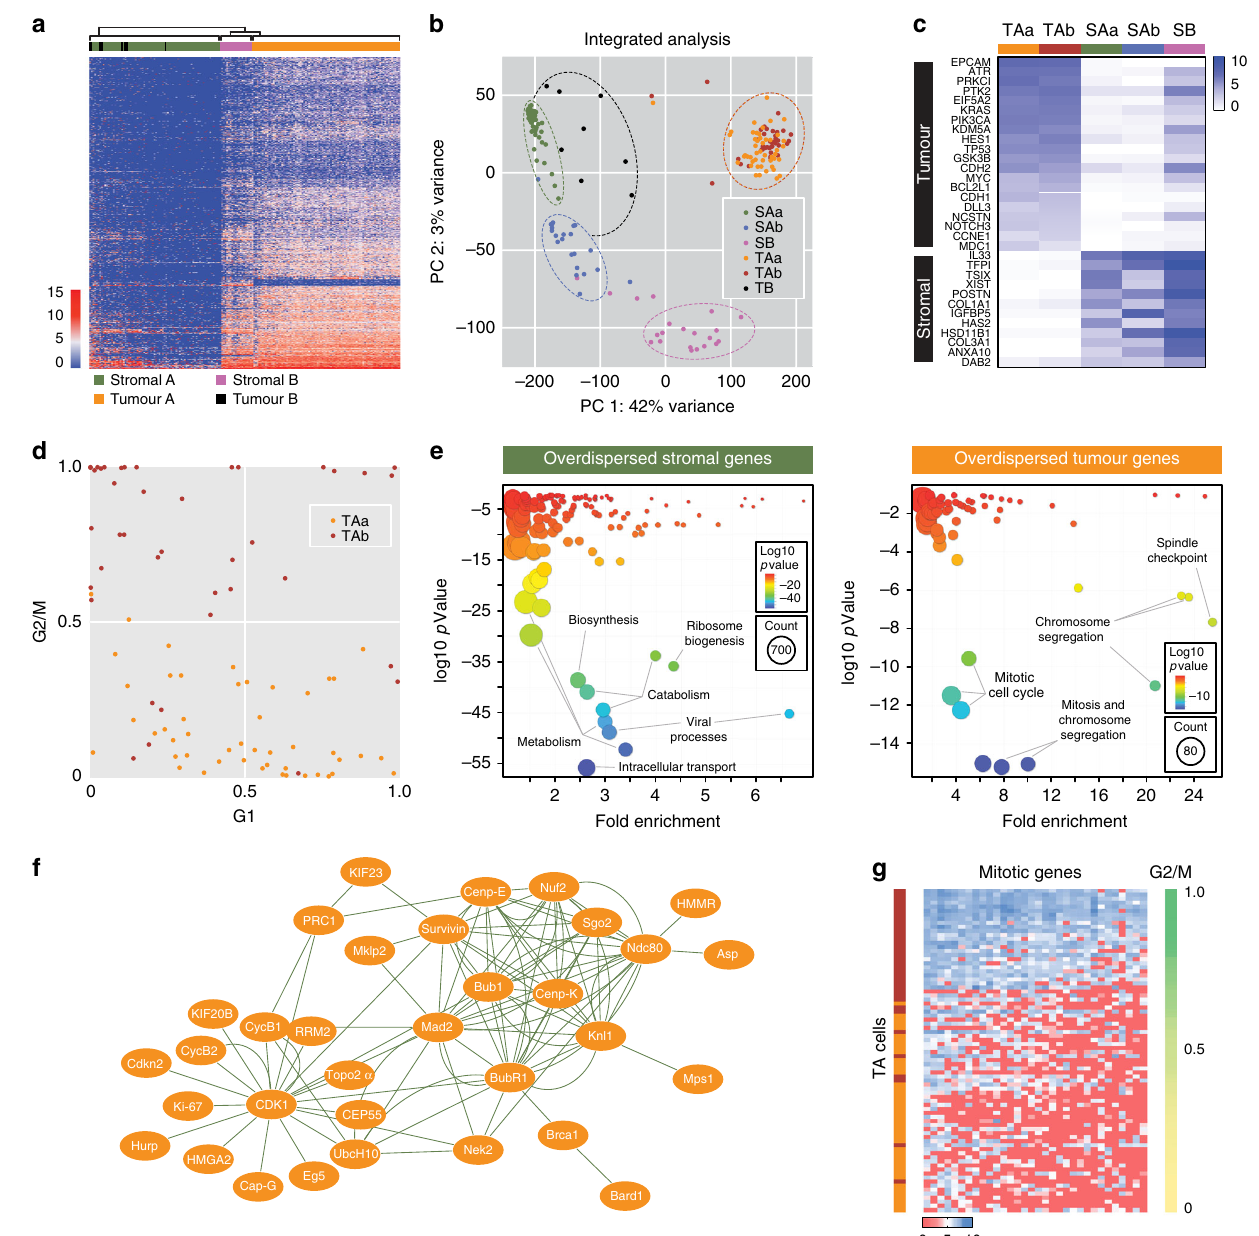
Fig. 4 Fluidigm single-cell transcriptomics. a Hierarchical clustering of gene expression pro fi les distinguishing stromal and tumour cells from chemo-naïve OCM.38a. b Principal component analysis integrated with pathway analysis showing subpopulations of tumour and stromal cells. c Heat map showing mean expression levels of selected genes in OCM.38a tumour and stromal sub-populations. d Scatter plots of G1 score versus G2/M score for individual cells within the TAa/TAb sub-populations. e Gene ontology analysis of overdispersed genes in stromal and tumour cells. f Network analysis of overdispersed genes in tumour cells. g Heat map of overdispersed genes showing that TAb cells expressing higher levels of mitotic genes and have high G2/M scores. Source data for panels b – e and g are provided as a Source Data fi